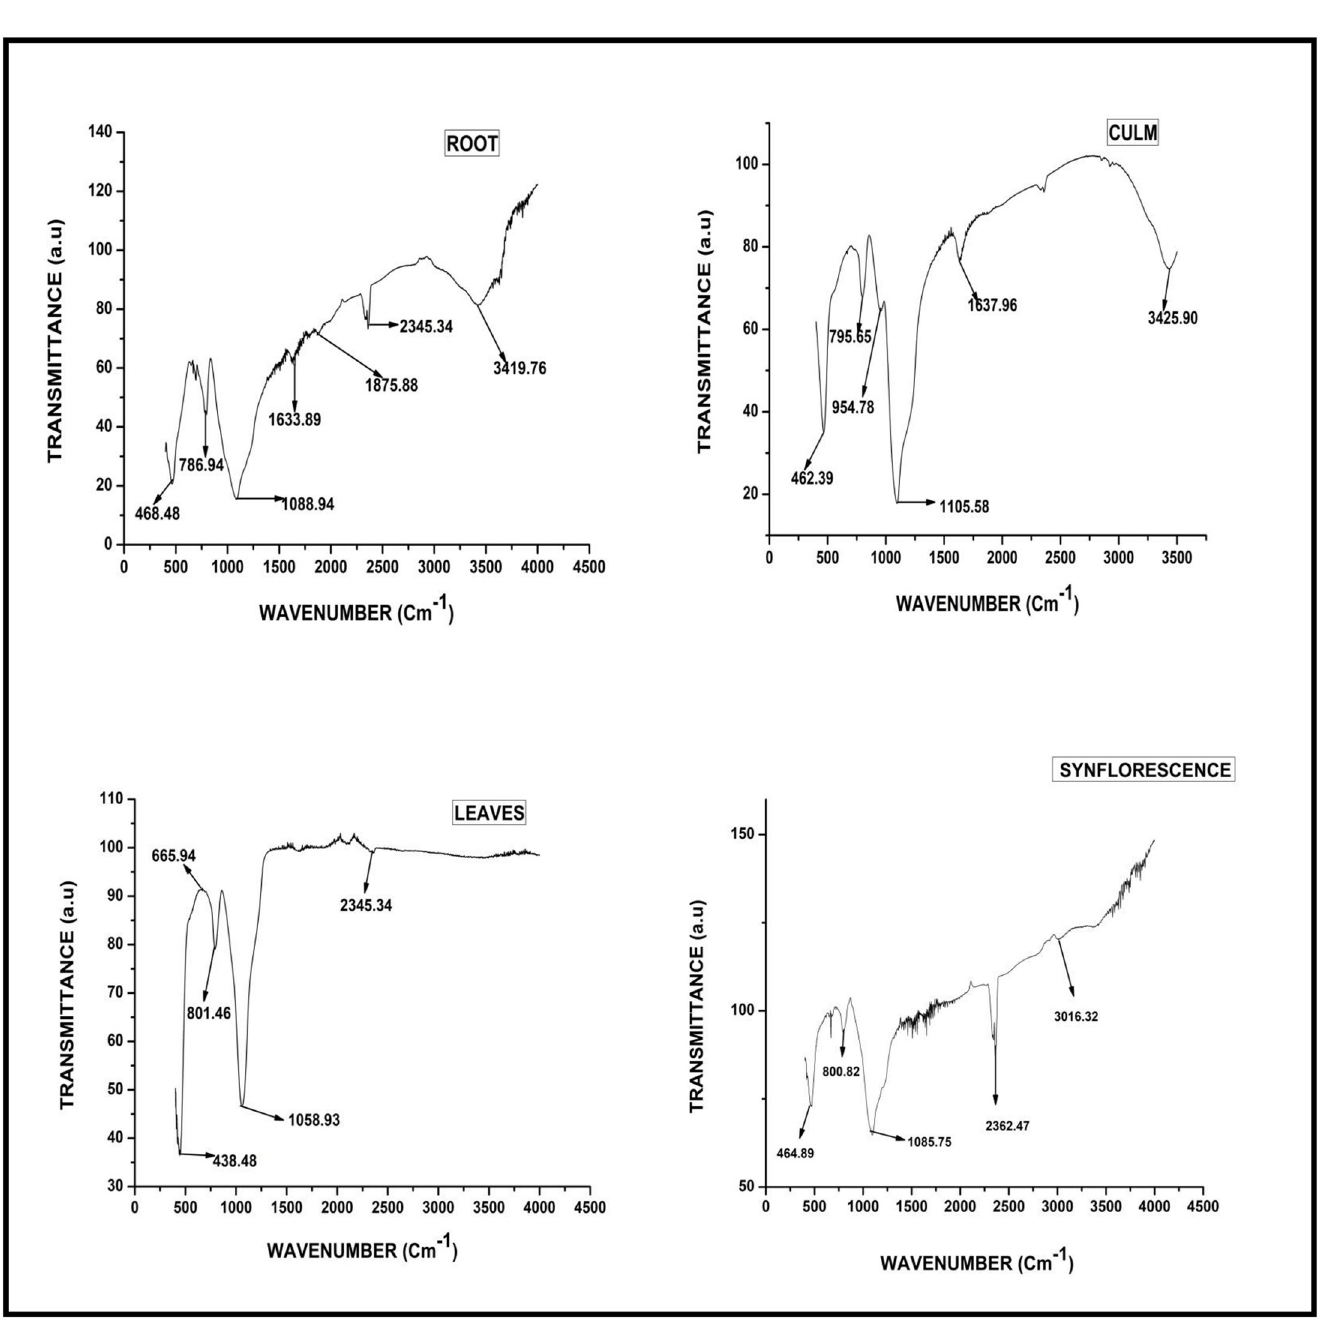
Fig 10. FTIR spectra of phytoliths from different parts of Acrachne racemosa (Heyne ex Roem. & Schult.) Ohwi.